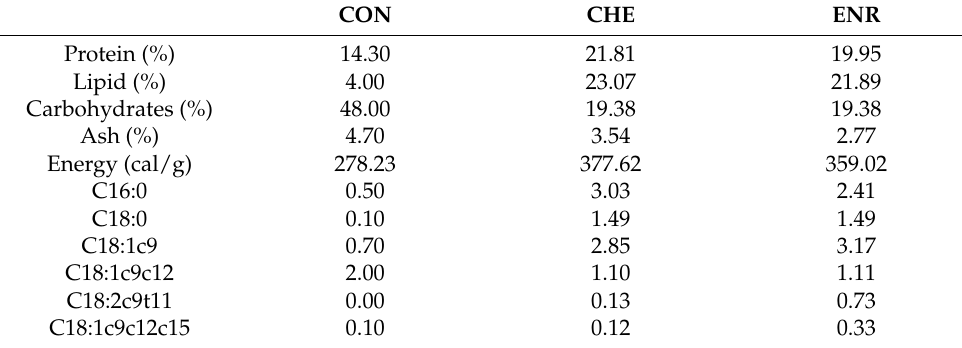
Table 1. Composition of the three